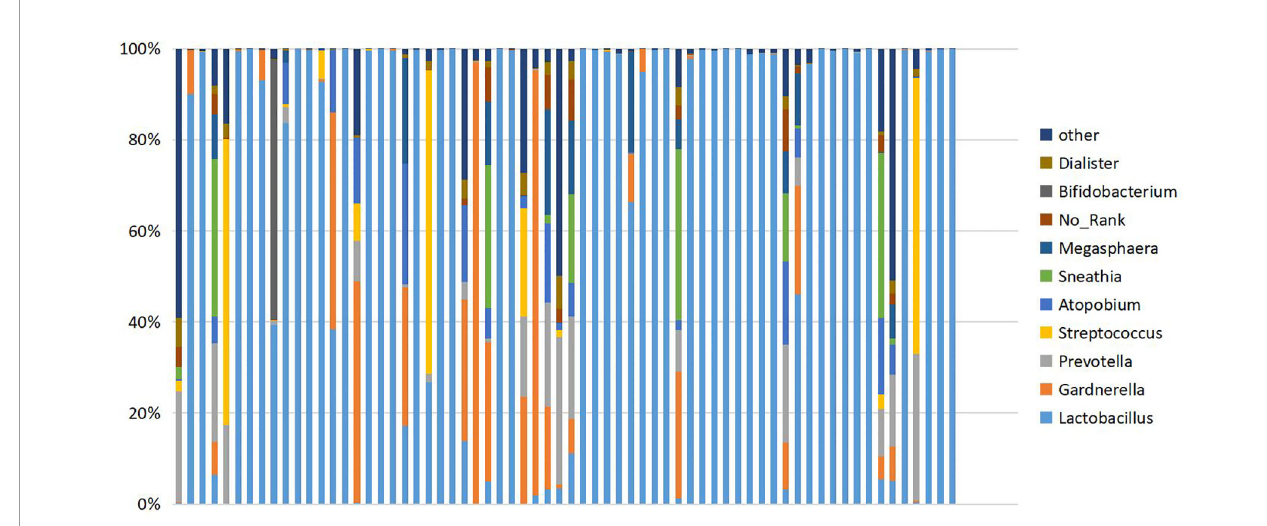
FIGURE 2 | Cumulative histogram showing the relative abundance of the vaginal microbiome at genus level. Ten species showing the highest relative abundance are